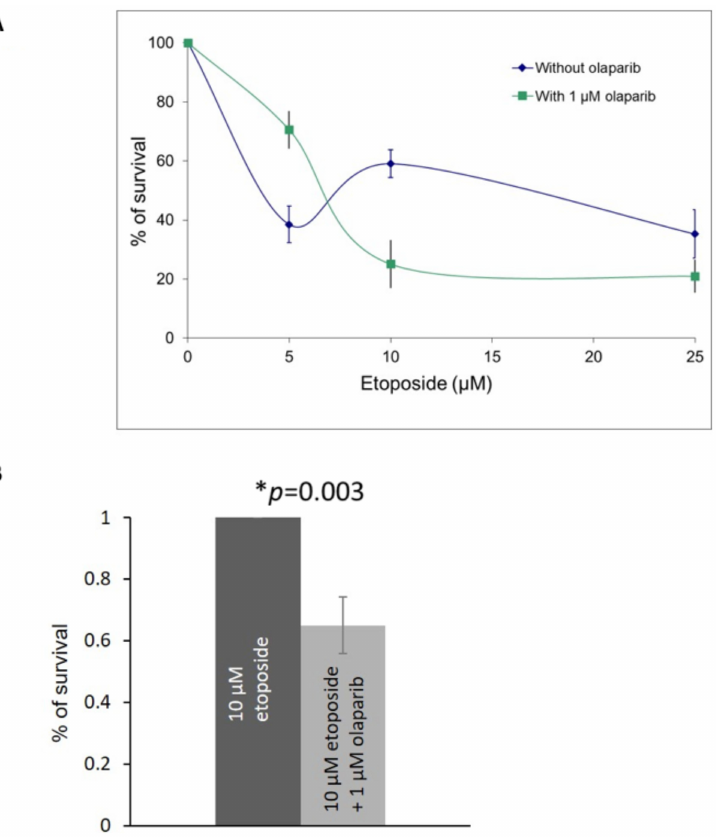
Figure 5. ( A ) MTT assay in primary retinoblastoma cells showed cell survival after co-treatment with 1 µ M olaparib with various dosages of etoposide for three days. Experiments were repeated three times. Data are shown as mean ± standard deviation. ( B ) MTT assay in primary retinoblastoma cells showed cell survival after co-treatment with 1 µ M olaparib and 10 µ M etoposide for three days. Experiments were repeated three times. Data are shown as mean ± standard deviation. and analyzed using two-tailed unpaired t -test. * represents statistical significance p =